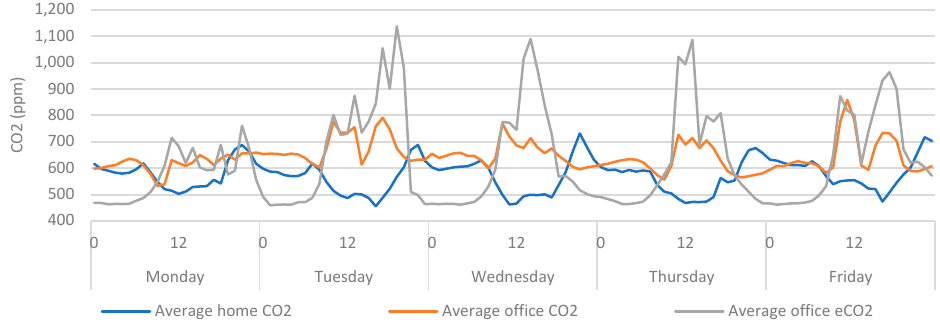
Figure 13. Average home/office CO 2 categorised by day > hour.